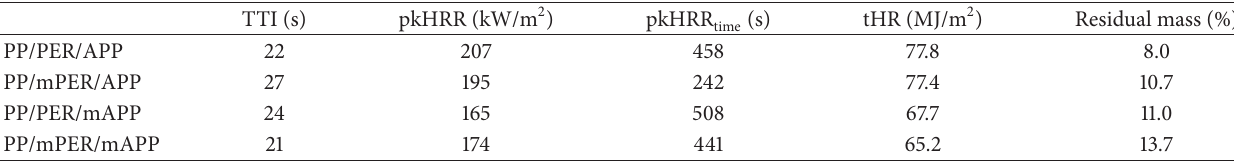
Table 2: Summary of the mass loss calorimetric test results.